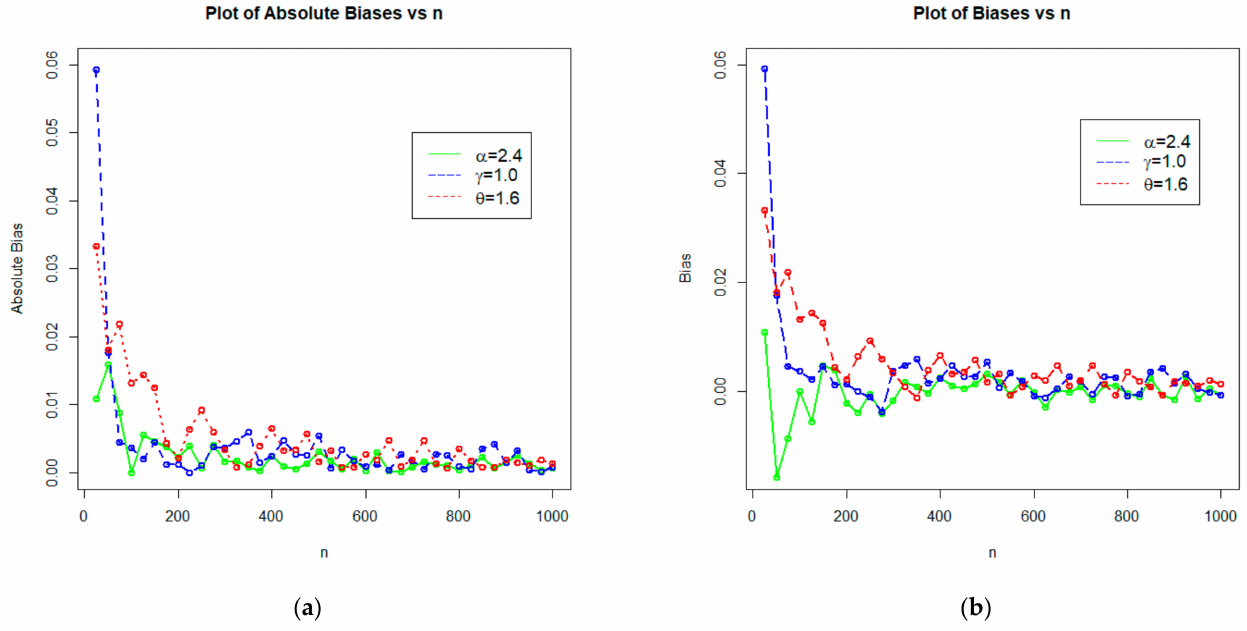
Figure 6. Plots of ( a ) absolute biases vs. n, and ( b ) biases vs. for Set 1: α = 1.4, γ = 1.0, θ =